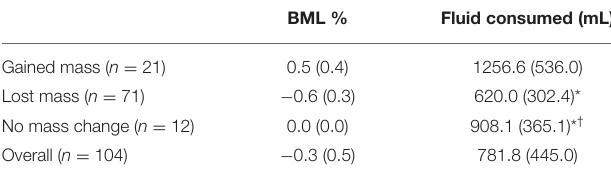
TABLE 2 | Overall and group means ±